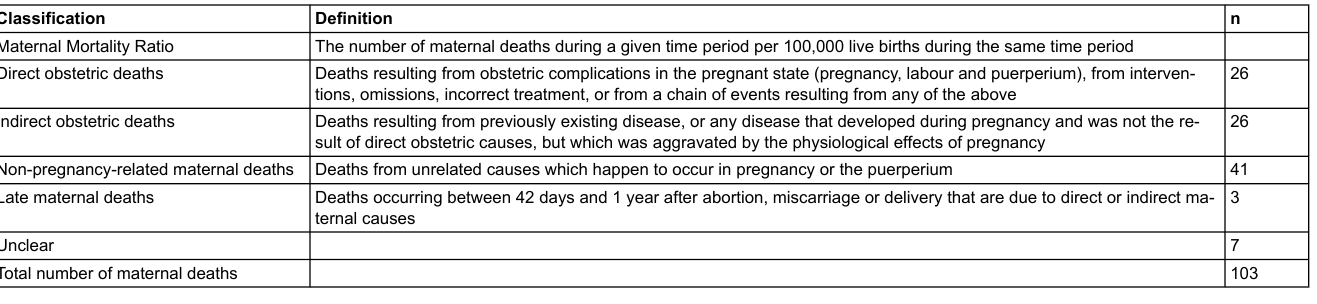
Table 3: Causes of death with classification. Cause of